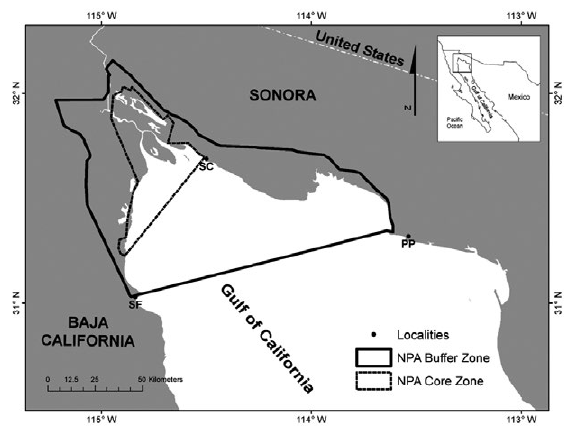
Fig. 1. – Location of the Northern Gulf of California Biosphere Re- serve and the Colorado River Delta, Mexico. San Felipe (SF), Santa Clara (SC), and Puerto Peñasco (PP) are the three main localities that carry out artisanal fishing of these species (CONANP